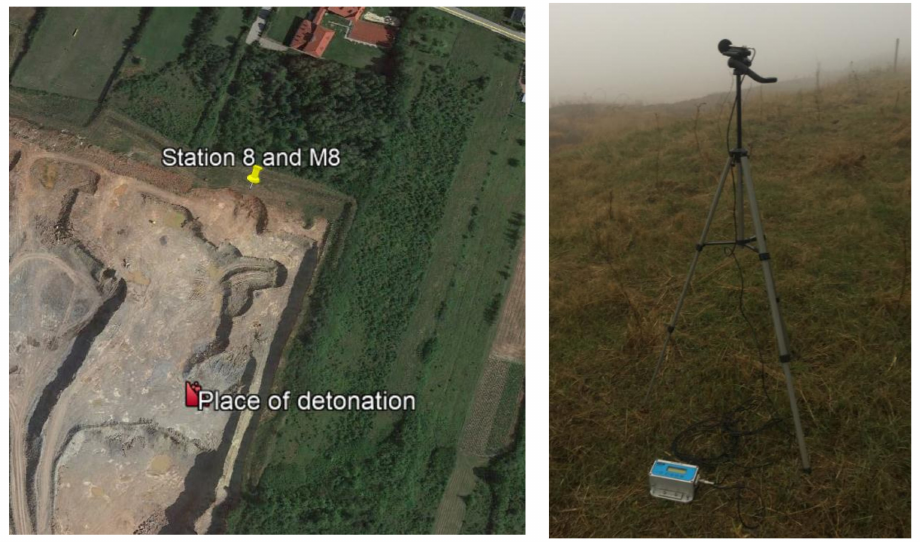
Figure 8. Blasting site and measurement